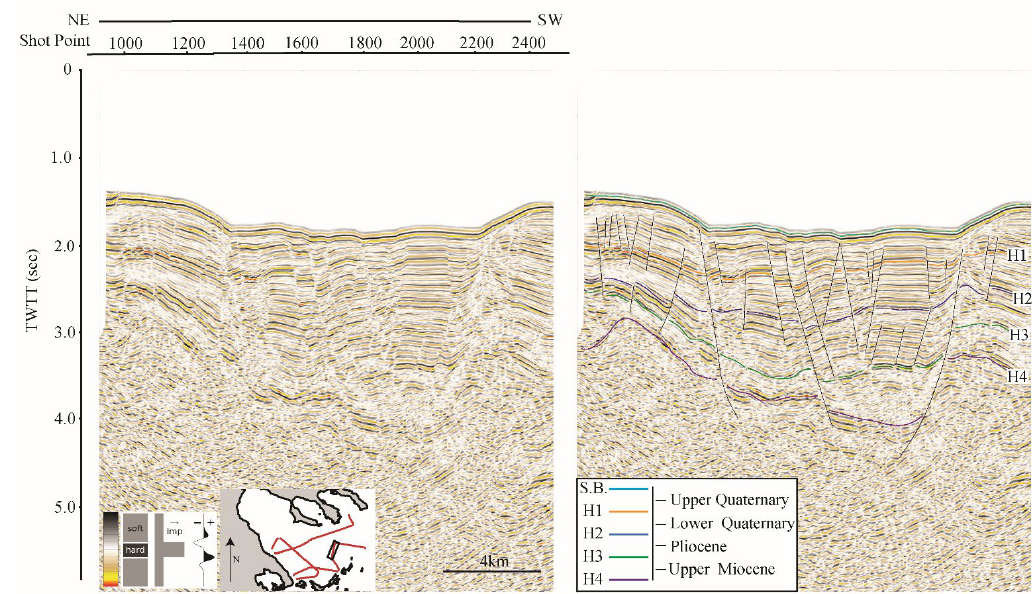
Figure 12. Seismic Line BC. Left part: un-interpreted set of regional seismic profiles. Right part: interpreted seismic section with highlighted key horizons and the most prominent tectonic elements.